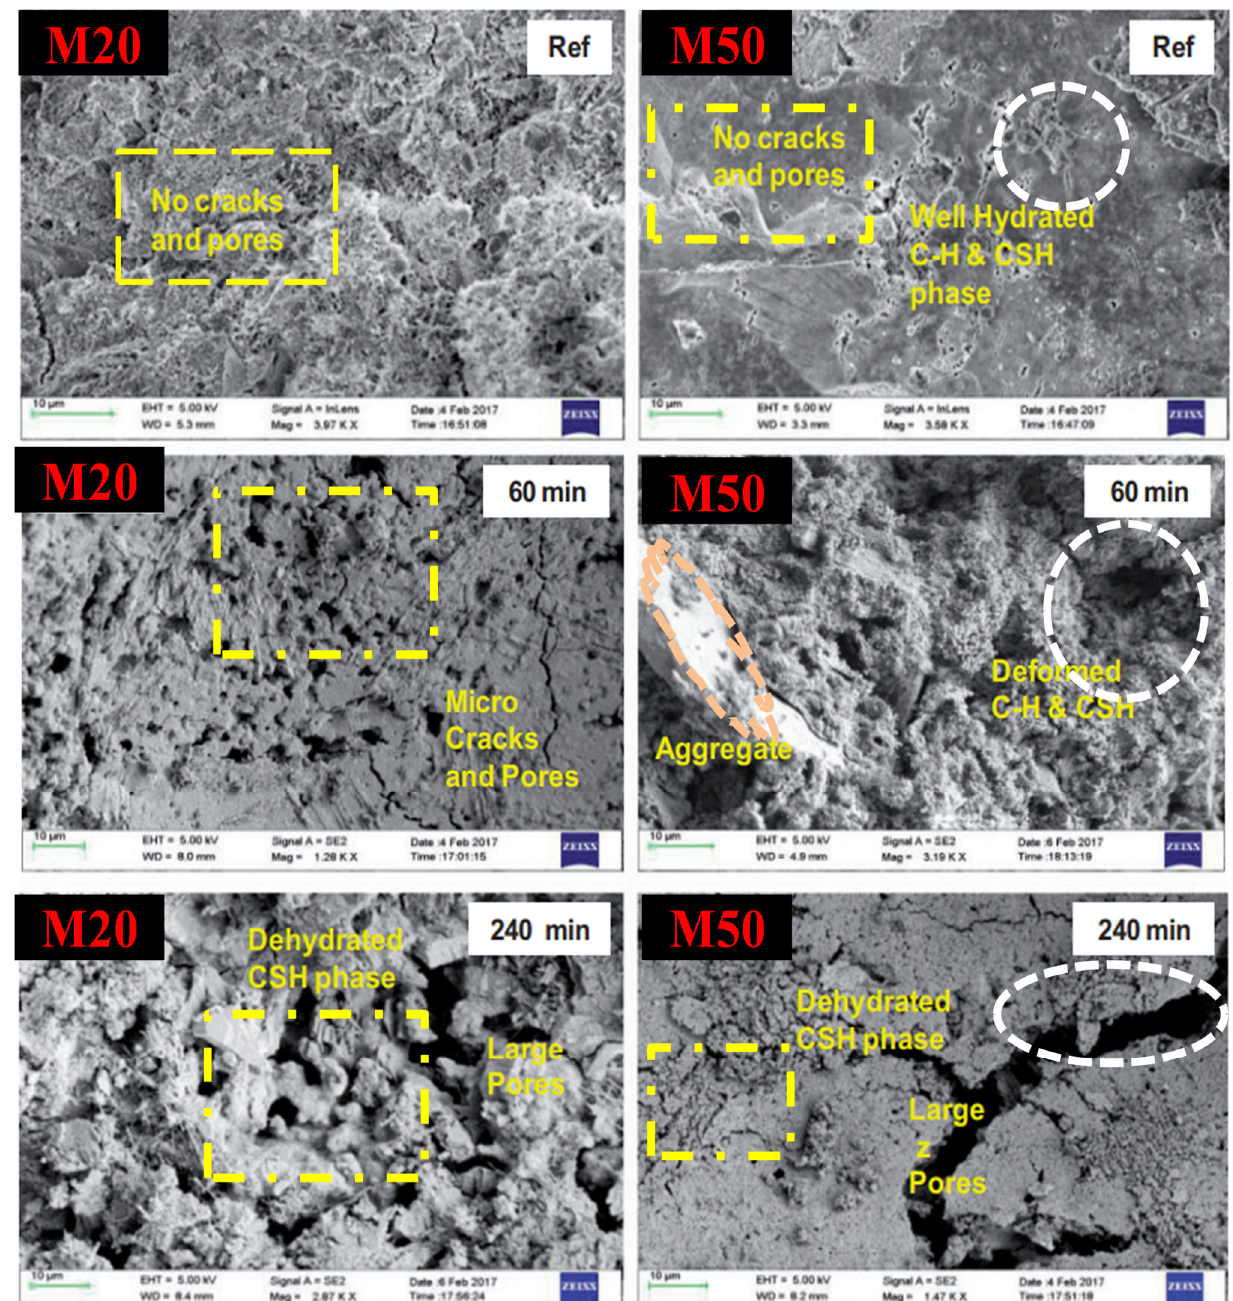
Figure 13. SEM images of M-20 and M-50 concrete exposed to high temperatures (Reference, 60 and 240